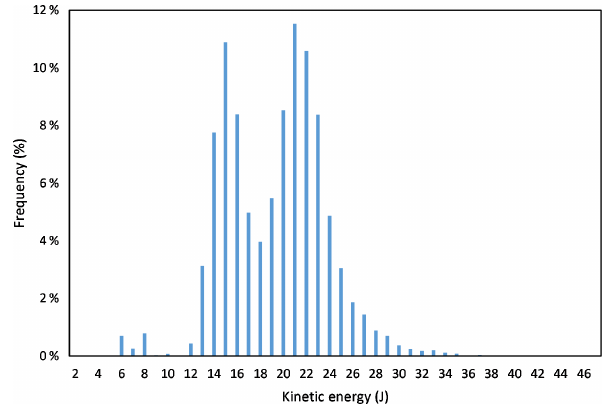
Figure 2. Modelled kinetic energy on impact of 5cm